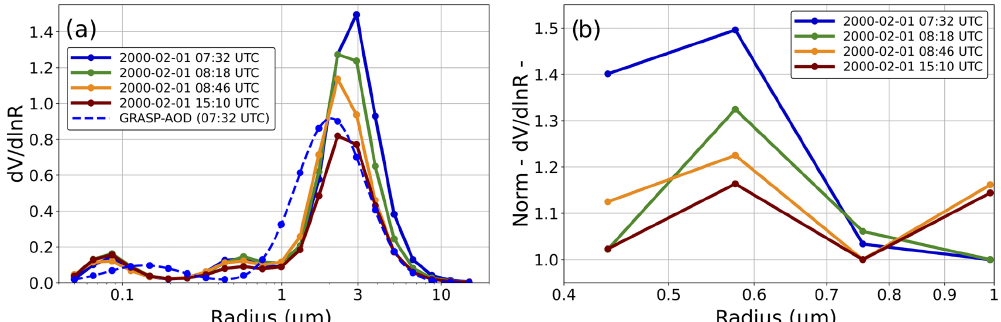
Figure 12. (a) Volume size distributions retrieved by the AERONET aerosol algorithm at the Ilorin site on 1 February 2000. The only valid retrieval from the GRASP-AOD, which corresponds to the τ measurement at 07:32UTC, is also plotted with a dash blue line. (b) The same volume size distributions retrieved by AERONET but only from 0.439 to 0.992µm (cutoff radius range used to separate modes in AERONET) and normalized by the minimum value at this interval. Table 9. Values of τ f ( 500 ) retrieved at the Ilorin site on 1 February 2000. The first two columns contain the values obtained by the AERONET aerosol retrieval algorithm and SDA. The rest of the columns correspond to simulated τ f ( 500 ) values estimated by the GRASP forward code using as input the aerosol properties retrieved by the AERONET and considering different cutoffs. Date and Time τ f ( 500 ) Simulated τ f ( 500 ) at different cutoffs (GRASP forward code) AERONET